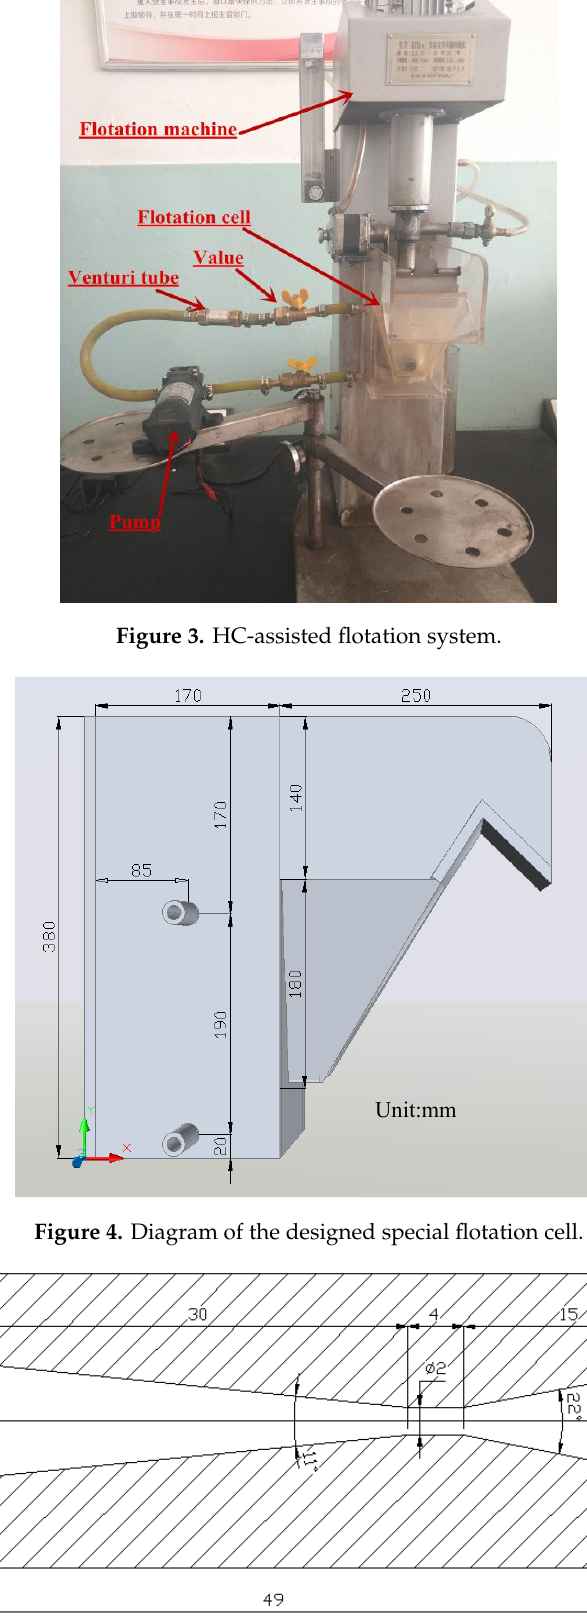
Figure 5. Structure parameters of the venturi tube.